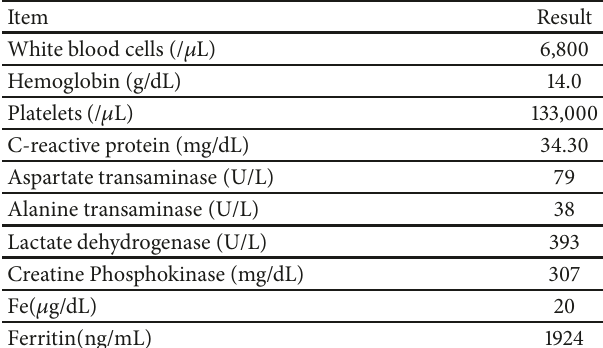
Table 1: Blood test findings.